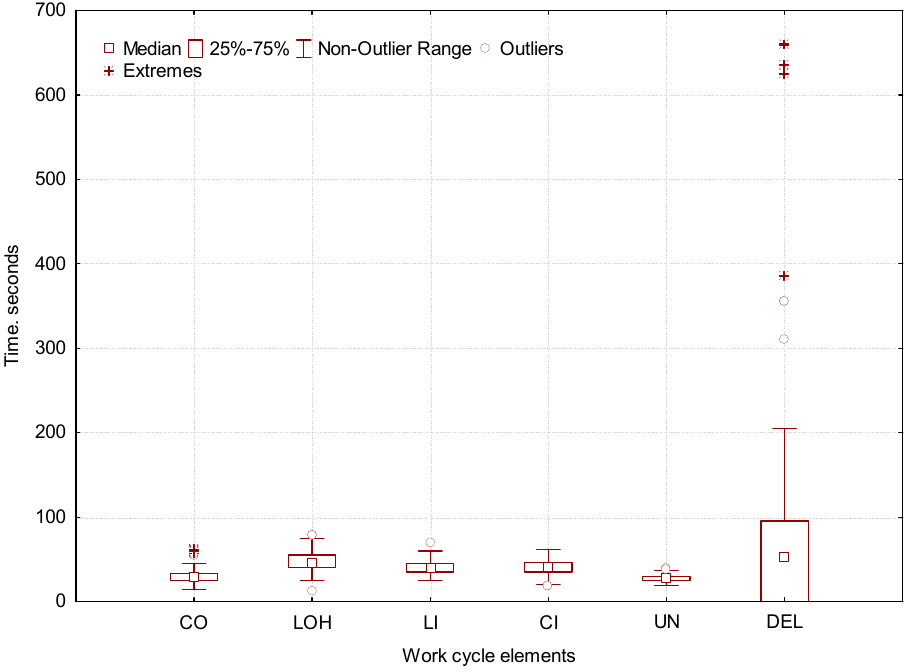
Figure 3. Elemental time consumption of tower yarder unit.